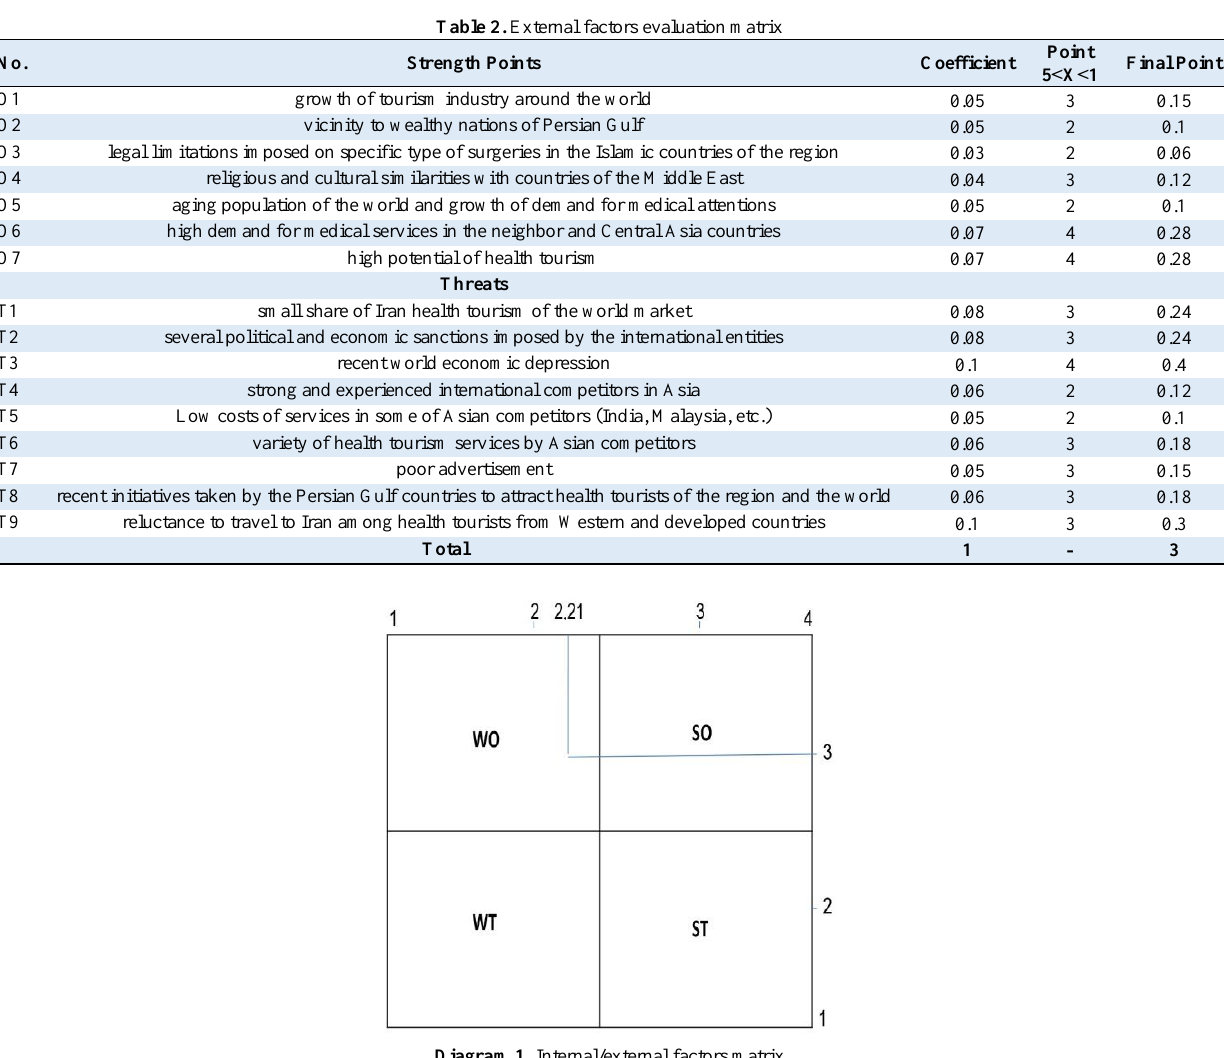
Diagram 1. Internal/external factors